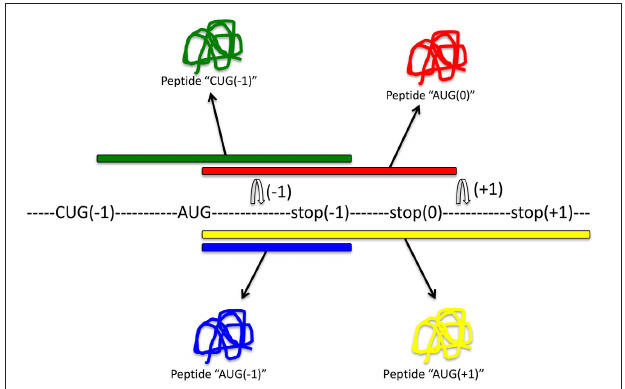
FIGURE 2 | Main sources for out-of-frame peptides. Regular expression of this mRNA with translation initiating tRNAmet will result in expression of peptide “AUG(0)” (red). Out-of-frame peptides could arise from alternative out-of-frame CUG or AUG start sites resulting in translation of peptide “CUG( − 1)” (green). Alternatively, − 1 or + 1 frameshift signals within the original reading frame could result in expression of out-of-frame peptides “AUG( − 1)” (blue) or “AUG( + 1)” (yellow),